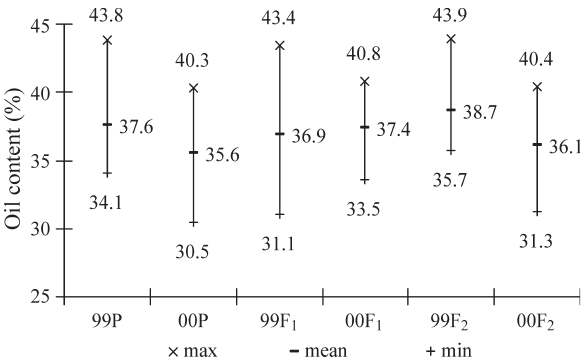
Figure 1 - Phenotypic distribution of generations for rape oil content. Par- ents = 99P (1999) and 00P (2000), F 1 = 99F 1 (1999) and 00F 1 (2000); F 2 = 99F 2 (1999) and 00F 2 (2000).